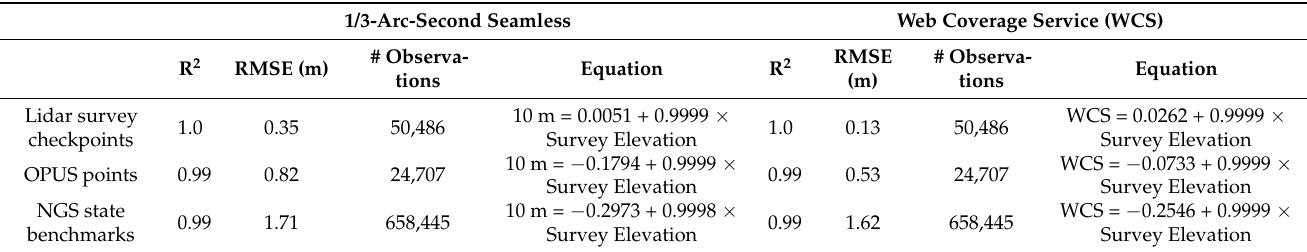
Table 17. Comparisons of root mean square error (RMSE) values by checkpoint types and digital elevation model type.